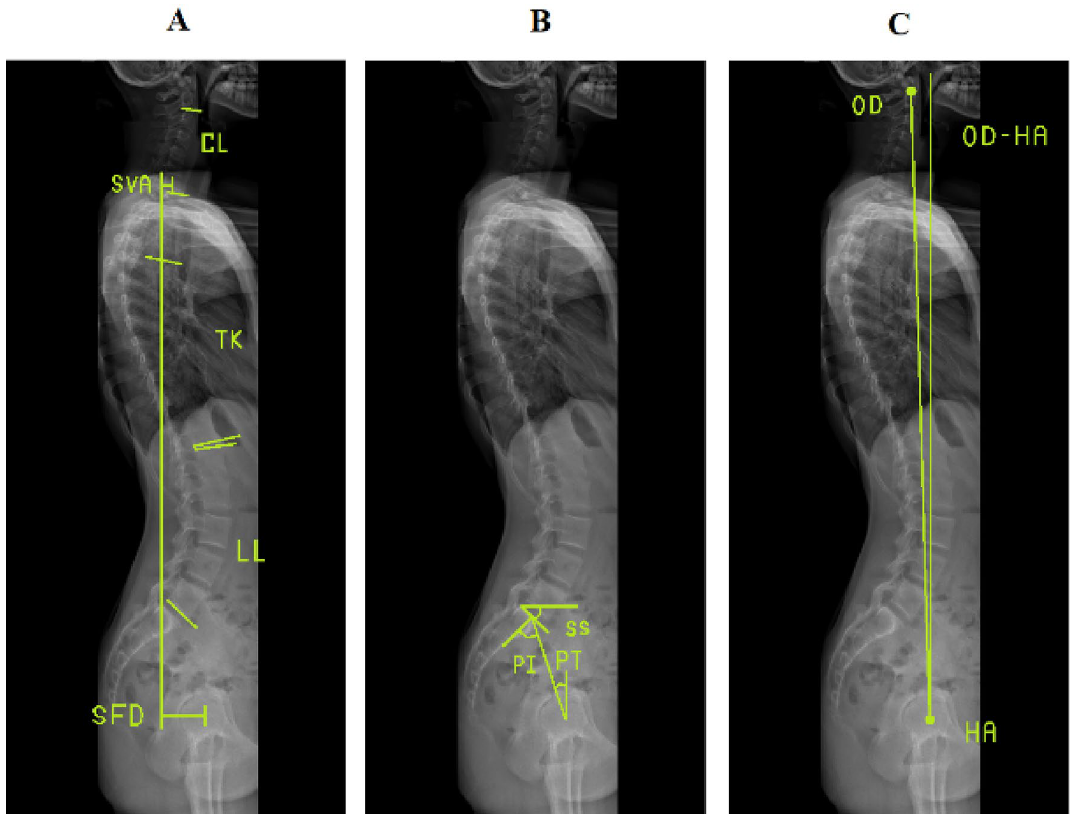
Figure 5. Illustration of measurements of spinal, pelvic and OD-HA parameters in sagittal radiography, including ( A ) CL cervical lordosis; TK thoracic kyphosis; LL lumbar lordosis; SVA sagittal vertical axis; SFD sacro-femoral distance; ( B ) PI pelvic incidence; SS sacral slope; PT pelvic tilt; and ( C ) OD-HA, odontoid-hip axis